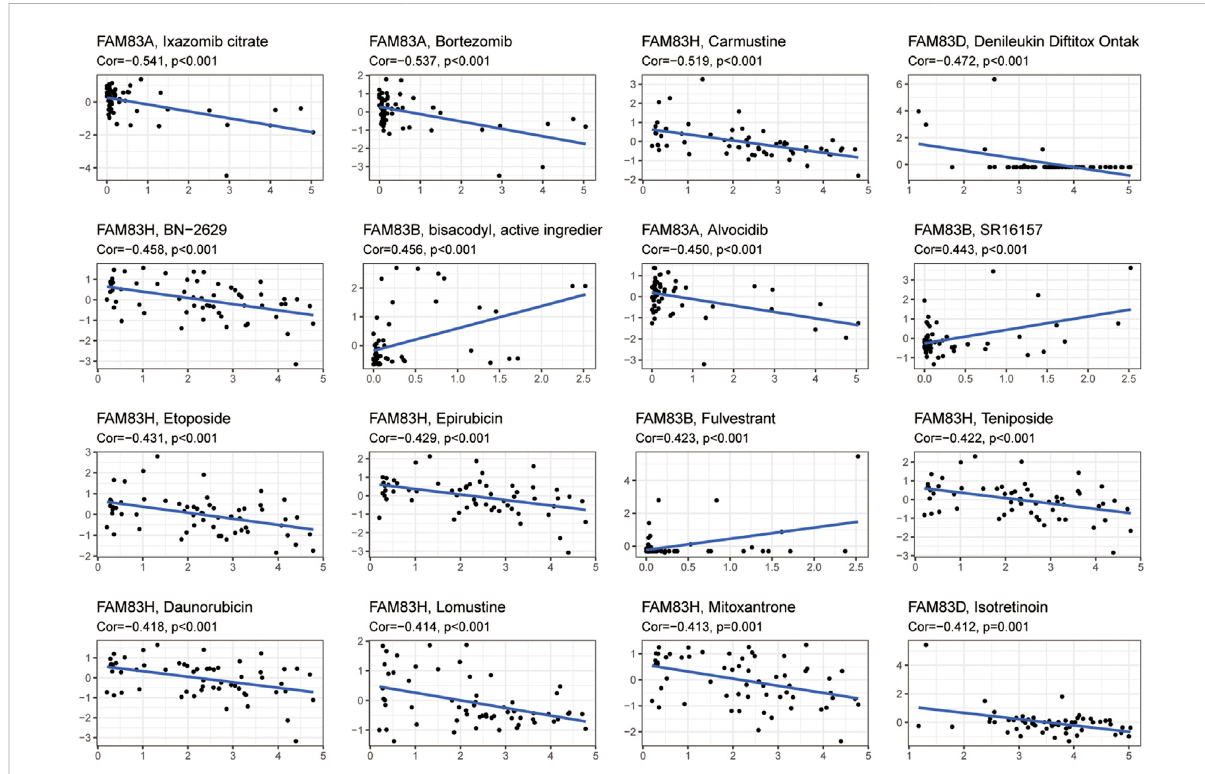
FIGURE 8 Correlation analysisbetweenFAM83familygeneexpressionanddrug sensitivity. Partialscatter plots areshown, andthescatter plots aresorted by p value by p < 0.05